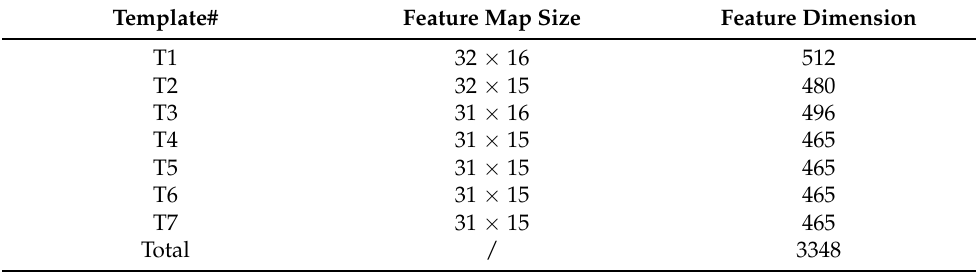
Table 1. The dimensions of the seven Subset-Haar-like